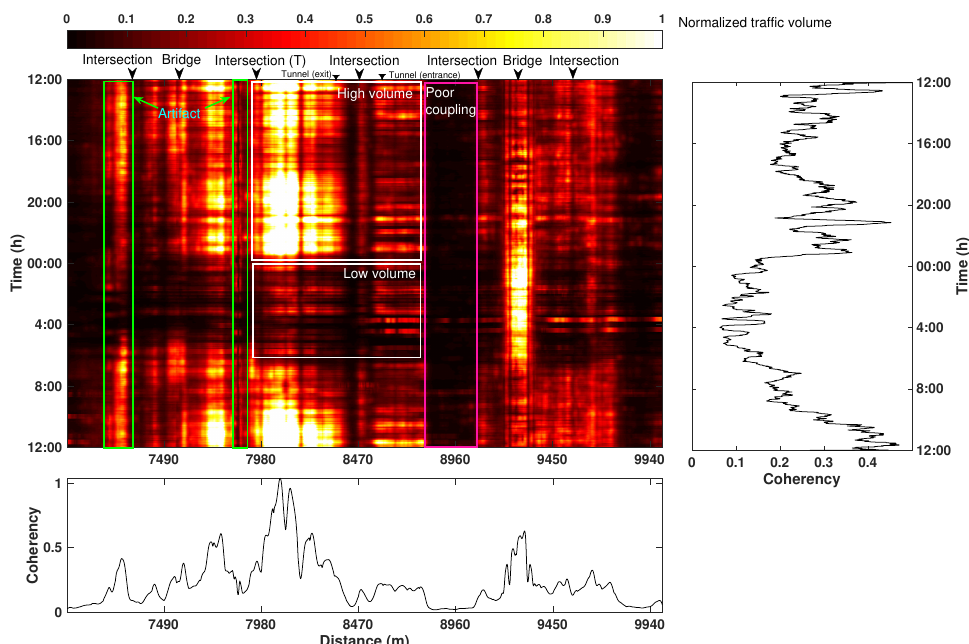
Figure 18. A 24-h spatiotemporal variation map of the correlation-based attribute. On the right side is the averaged result along the spatial direction. On the bottom is the averaged result along the temporal direction. Some typical landmarks causing these features are marked on the top of the 2D map.